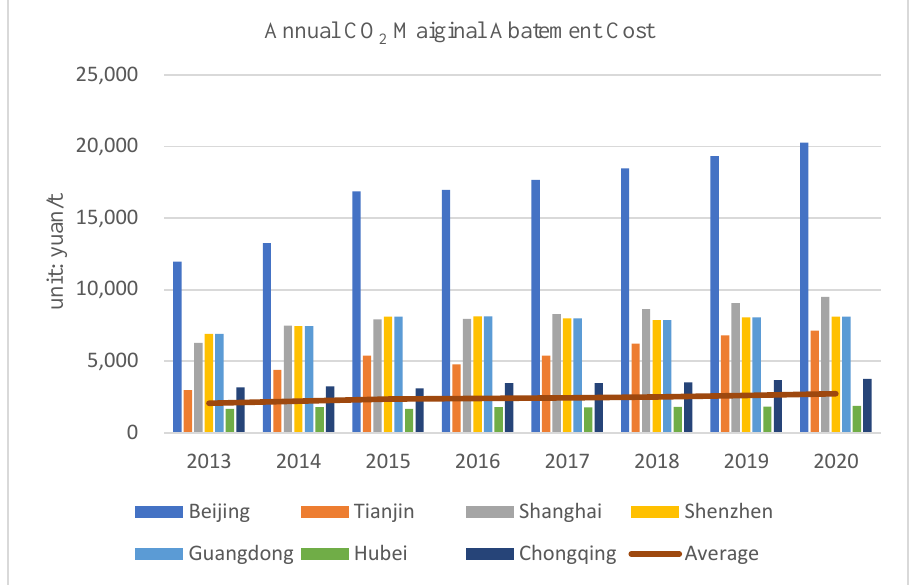
Figure 3. The average annual MAC across all seven carbon pilots.